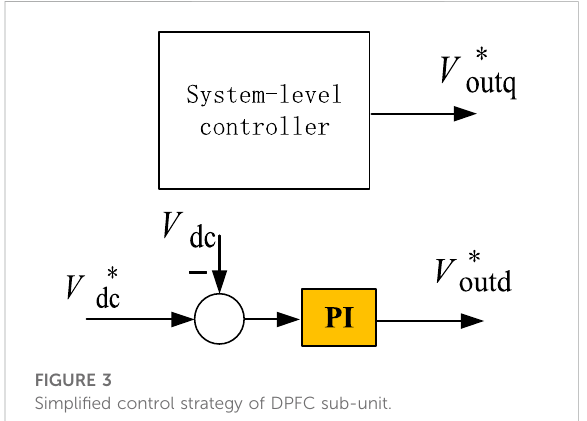
FIGURE 3 Simpli fi ed control strategy of DPFC